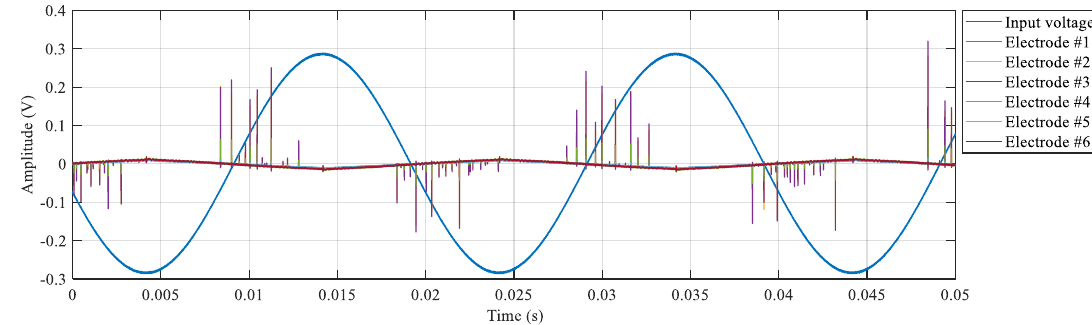
Figure 12. Measured voltage from the monitor and the electrodes, joint #2 (at nominal voltage).